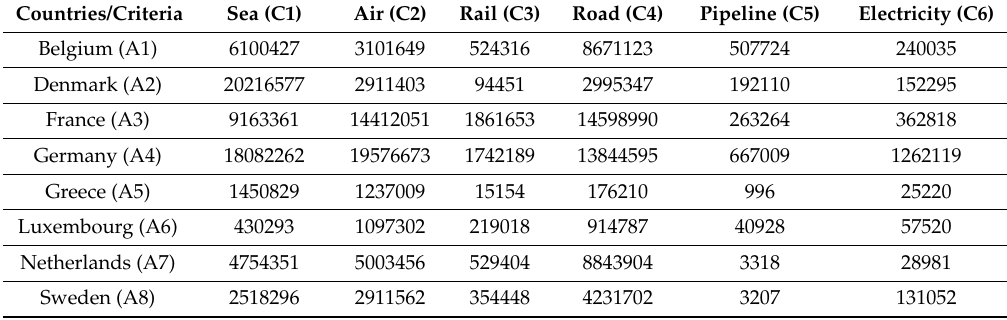
Table A5. Selected Data of Transport Import for the EU by 2016 (US Dollar,